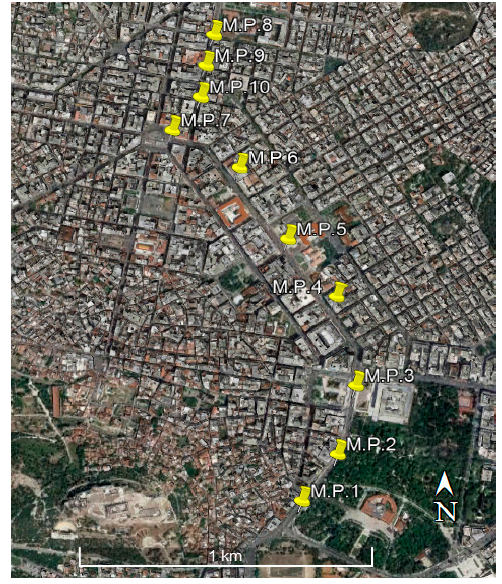
Figure 2. The measuring points in the center of Athens.